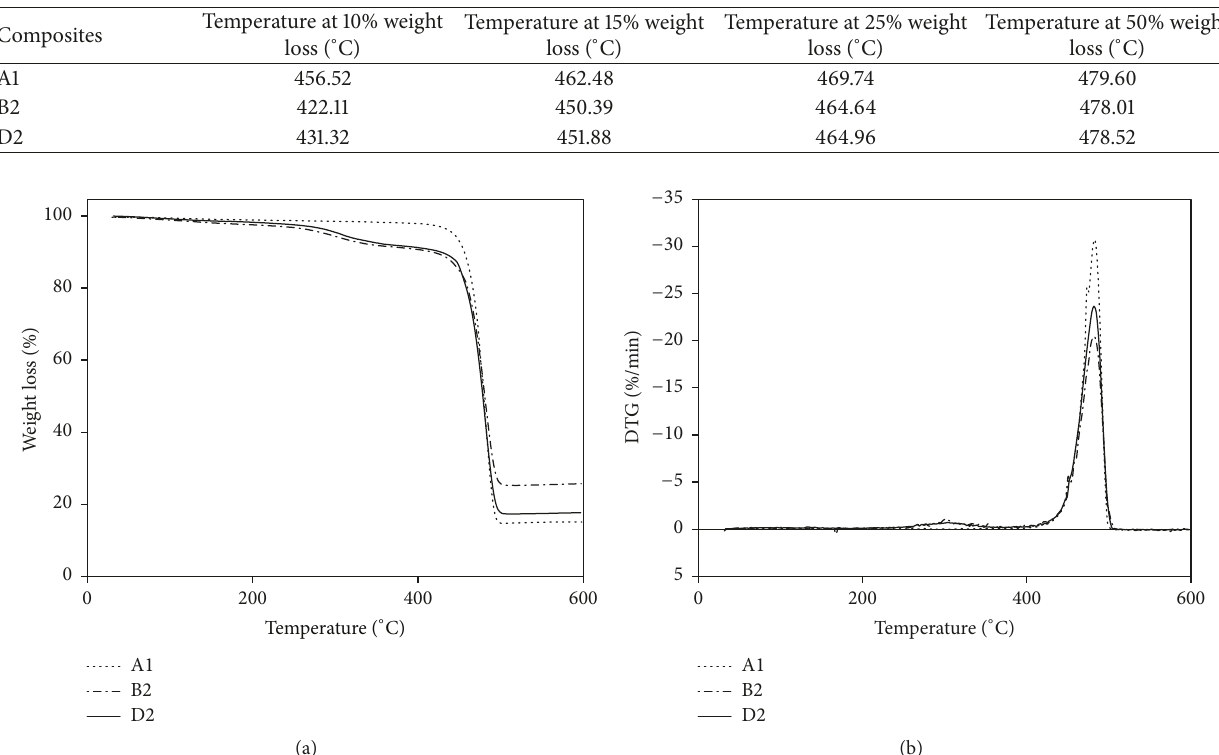
Table 3: Degradation temperature (in ∘ C) of composites types A1, B2, and D2.